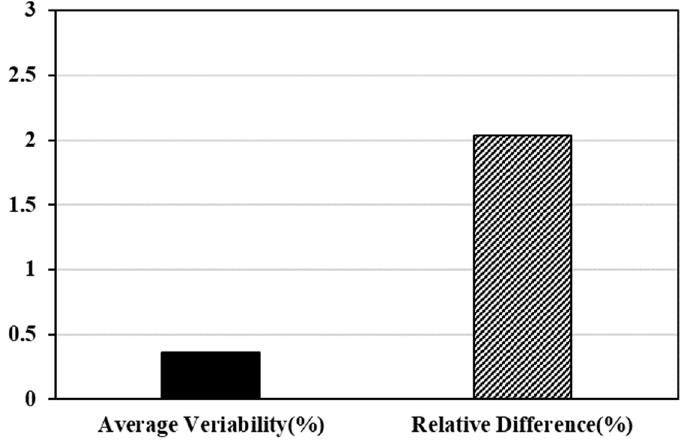
Figure 5. Variability results of ultrasonic velocity investigation methods.